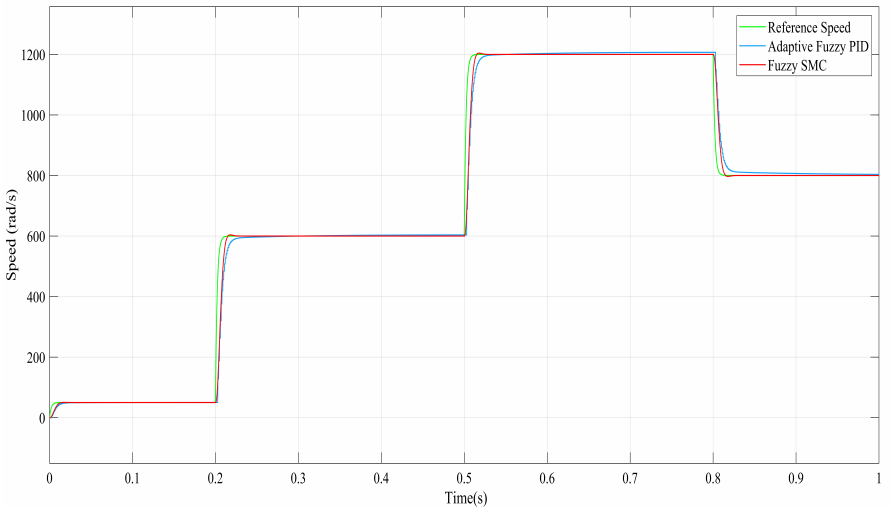
Figure 17. Measured speed change with adaptive fuzzy PID and fuzzy